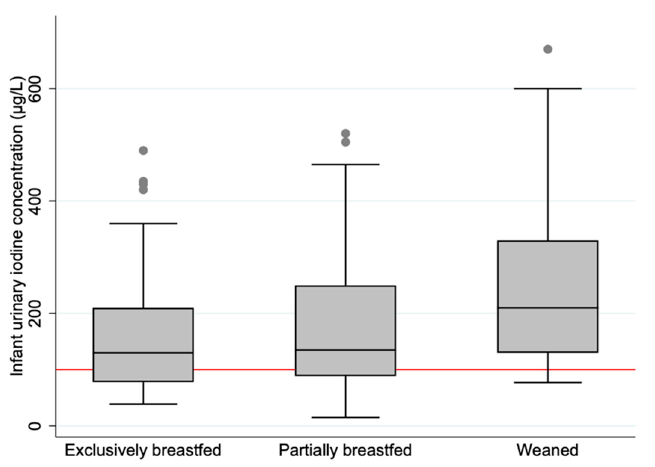
Figure 2. Boxplot displaying infant urinary iodine concentration (µg/L) in the three categories of breastfeeding status. The horizontal black line indicates the median; the boxes indicate the interquartile range (IQR); the whiskers represent observations within 1.5 times the IQR. The red line shows the recommended median value for sufficient iodine concentration in urine ( ≥ 100 µg/L). Table 3. Non-parametric regression model of the univariate association between maternal and infant characteristics and infant urinary iodine concentration ( µ g/L) ( n = 130). Numbers are presented as β with 95% confidence